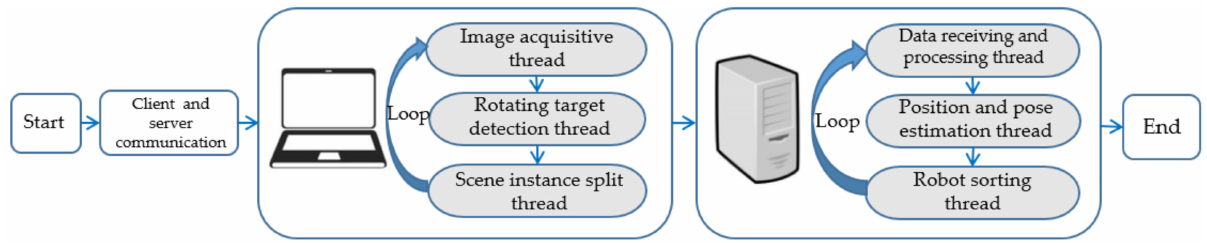
Figure 2. Operation process of robot sorting system